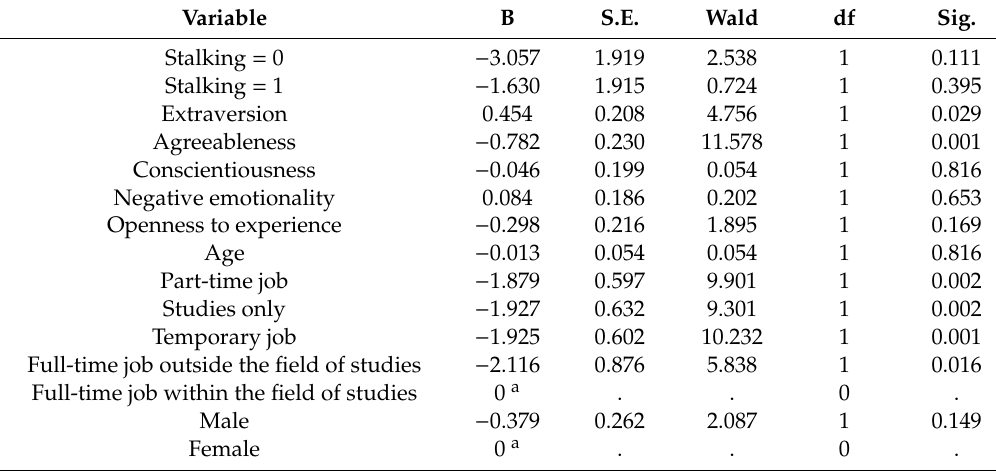
Table 3. Full Model 2—Stalking: ordinal logistic regression.